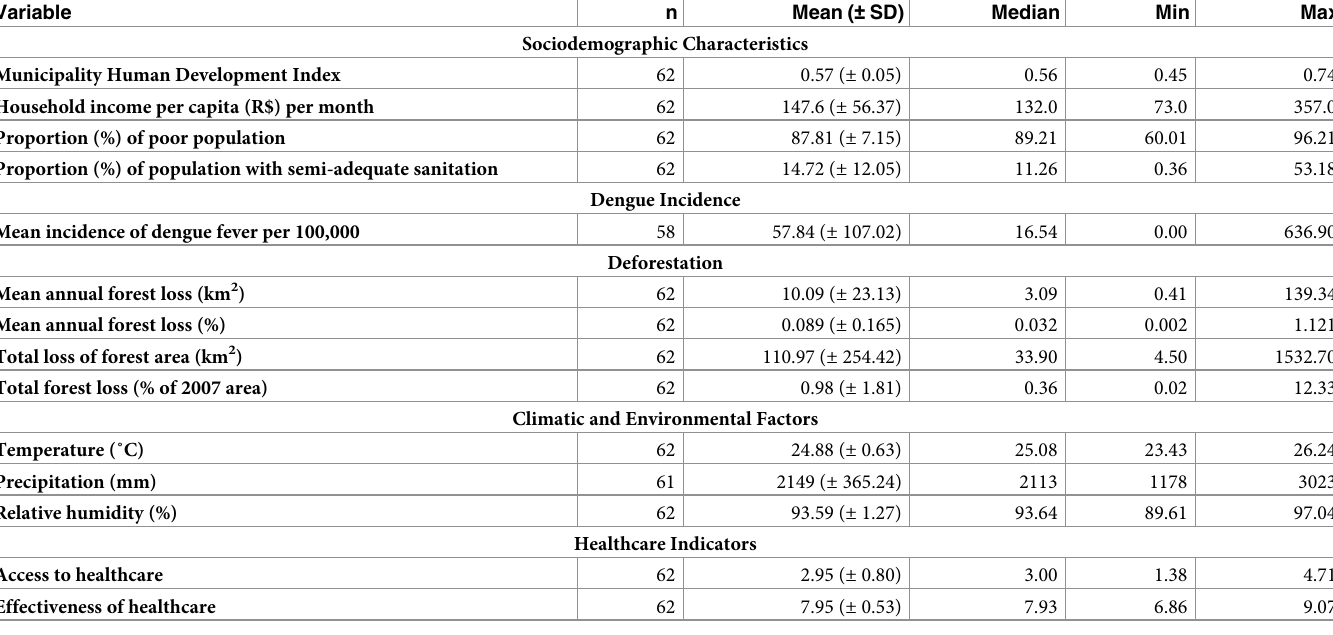
Table 1. Description of the study